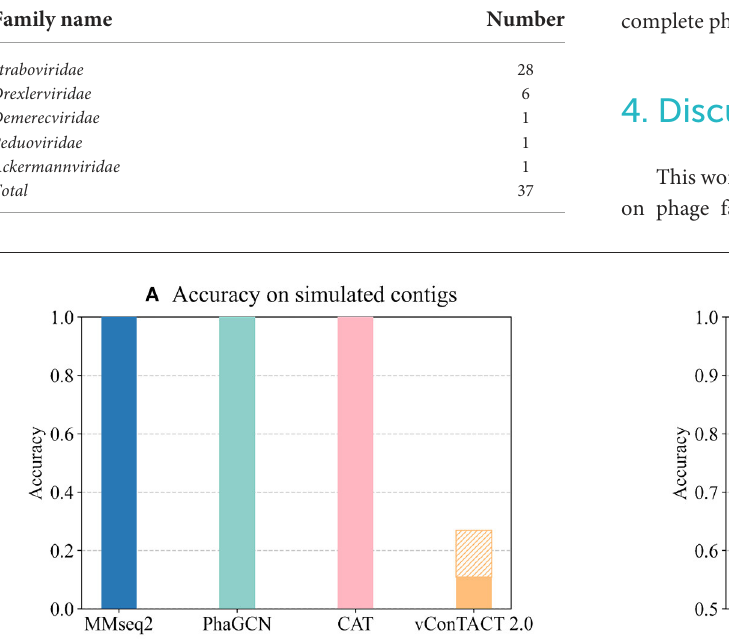
TABLE 5 Family composition of the simulated metagenomic dataset.